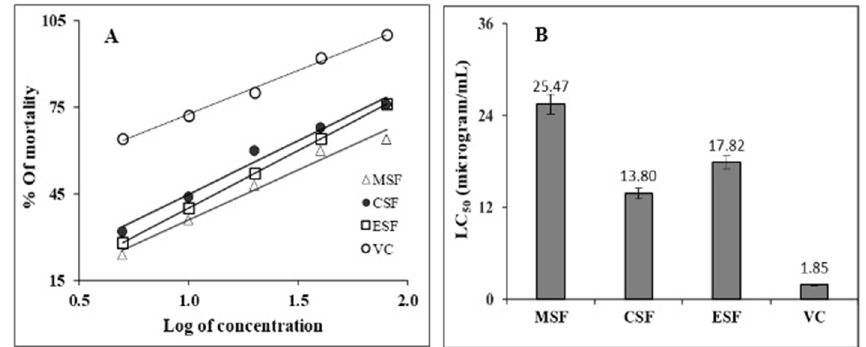
Fig. 2 Cytotoxicity of the different fractions of C. asiatica against brine shrimp. A Graph plotted for log of concentration versus % of mortality of